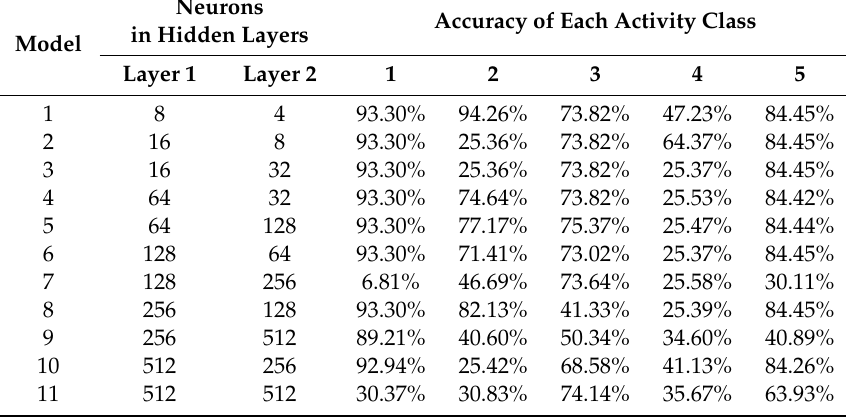
Table 9. Scoring result of training dataset A (19 July 2019 interval) and evaluation dataset B (26 July 2019 interval).